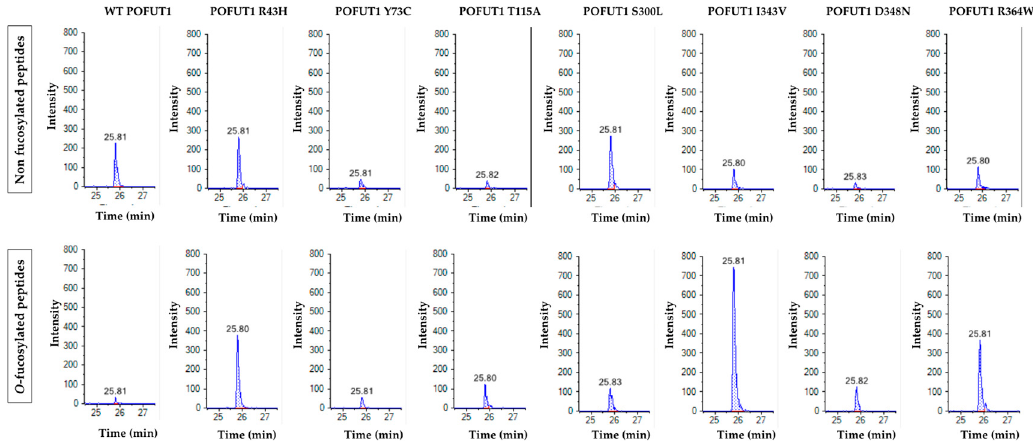
Figure 4. Multiple reaction monitoring mass spectrometry (MRM-MS) analyses of trypsin-digested WT EGF-LD26, after incubations with GDP-fucose and either WT POFUT1 or mutated POFUT1 variants independently. Peaks corresponding to non-modified peptides (upper panels) and peptides modified with O -fucose (lower panels) were shown for WT POFUT1 and all POFUT1 variants. Peaks correspond to the most intense MS2 fragment signal, obtained during the run time.